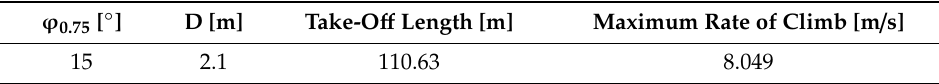
Table 5. Point on the Pareto front for take-o ff distance (take-o ff engine regime) and maximum rate of climb (take-o ff engine regime) (see Figure 10).